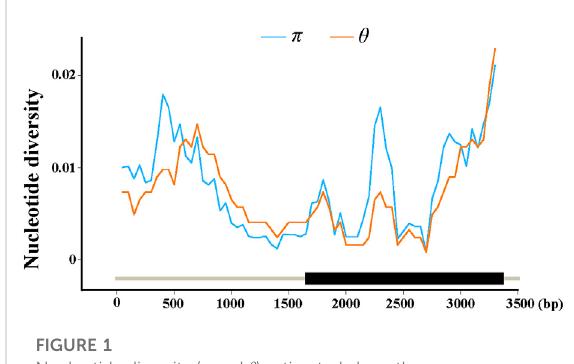
FIGURE 1 Nucleotide diversity ( π and θ ) estimated along the sequences of maize ZmFWL7. π and θ were calculated using the method of slidingwindowsof200 bpwithastepof50 bp.Thegenestructure was indexed at the bottom of the